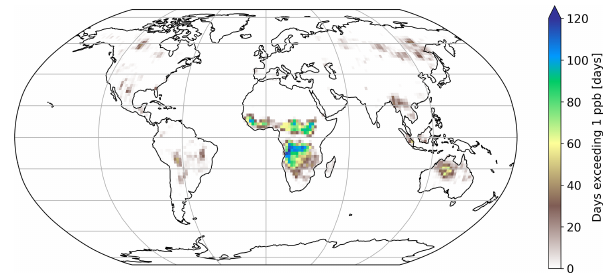
Figure 6. Number of days exceeding 1ppb of HNCO at the surface. Biomass burning emission factors are based on Koss et al.